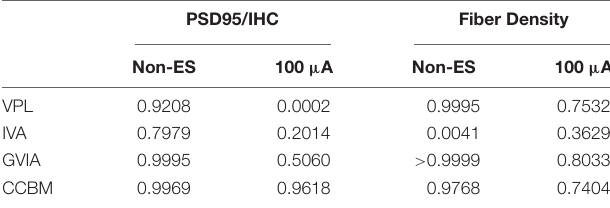
TABLE 3 | P value of fiber density and PSD95/IHC ratio of the Non-ES/Ca − , Non-ES/Cd, 100 µ A/Ca − and 100 µ A/Cd group compared with Non-ES